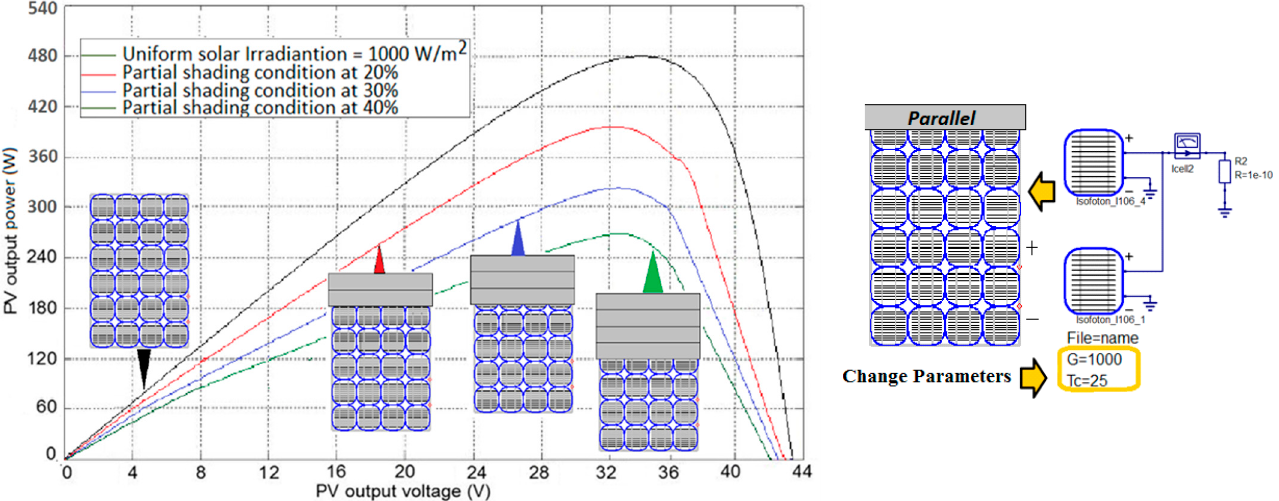
Figure 12. Power-Voltage (power characteristics) under different partial shading conditions for parallel approach.